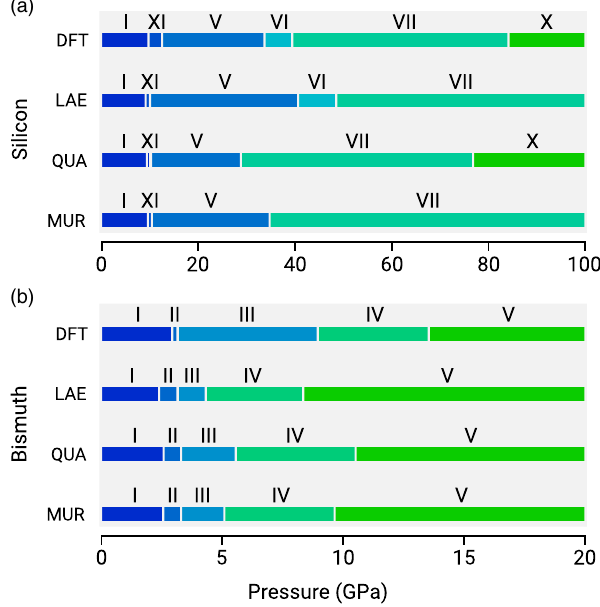
FIG. 2. The pressure range of stability of high-pressure phases of elemental (a) silicon and (b) bismuth. Explicitly computed transition pressures using DFT-calculated formation enthalpies are labeled “ DFT ” (top bar in each panel), and those based on the LAE are denoted with “ LAE ” (second bar in each panel). In addition, we show transition pressures calculated using the expansion of the enthalpy to second order ( “ QUA ” ) and the Murnaghan EOS ( “ MUR ” ) [51,52], for comparison. The crystal structures of the silicon and bismuth allotropes were taken from Refs. [44 – 50] and [53 – 59],